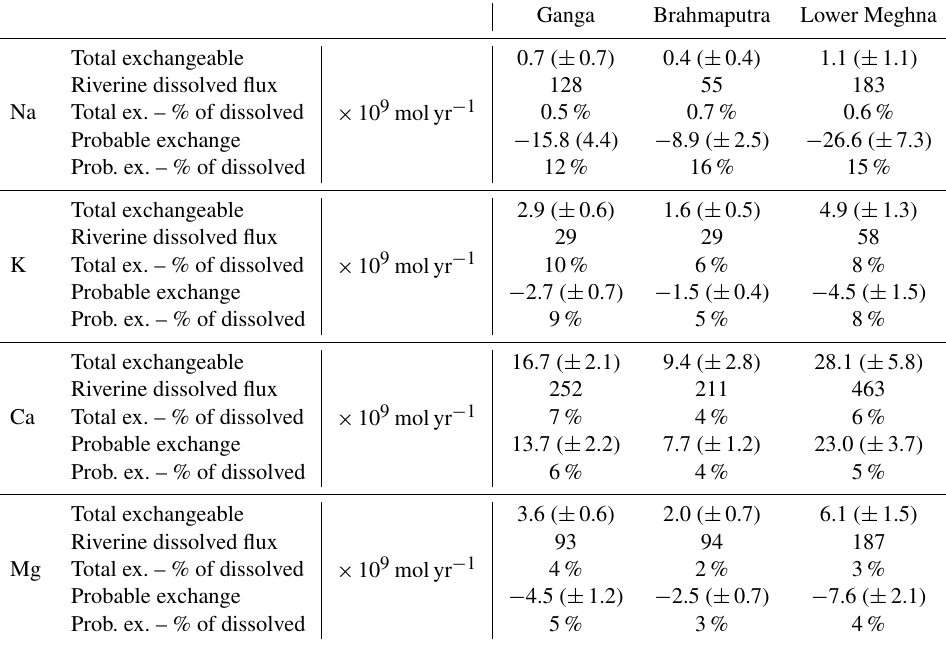
Table 3. Total exchangeable flux of major cations bound to the sediment in river water and most probable exchange fluxes taking place during interaction of G&B sediments with seawater based on the measured total exchangeable cations and the effective exchange proportions of Sayles and Mangelsdorf (1977, 1979). These fluxes are compared to the riverine dissolved fluxes as given by Galy and France-Lanord